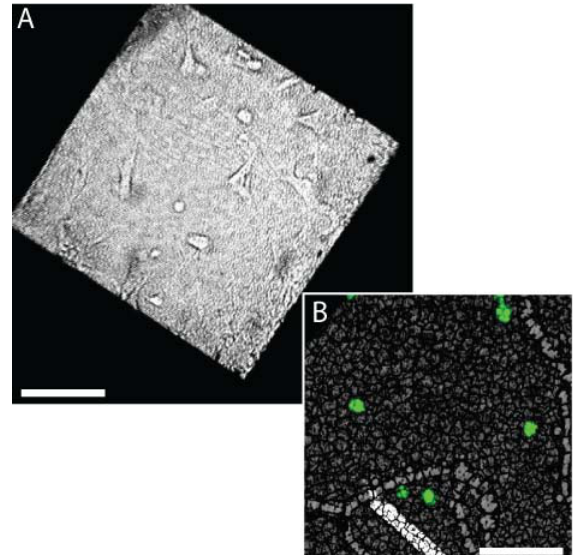
Figure 5. (A) Micrographs on adherent epithelial A-431 cells growing on titania coated microwells. (B) Calcein-AM labeled live cells (green) in suspension (A-431 cells) on titania coated microwell. Enlargement from a microwell. Scale bars: A: 200 µm, B:100